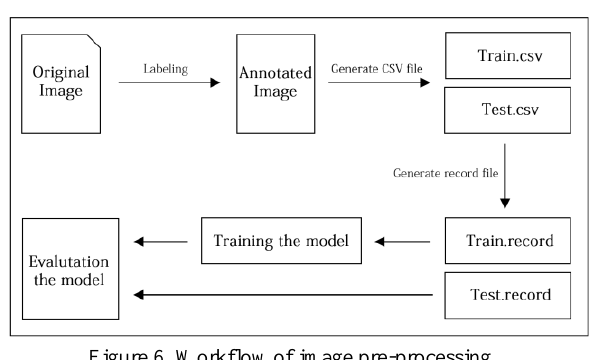
Figure 6. Workflow of image